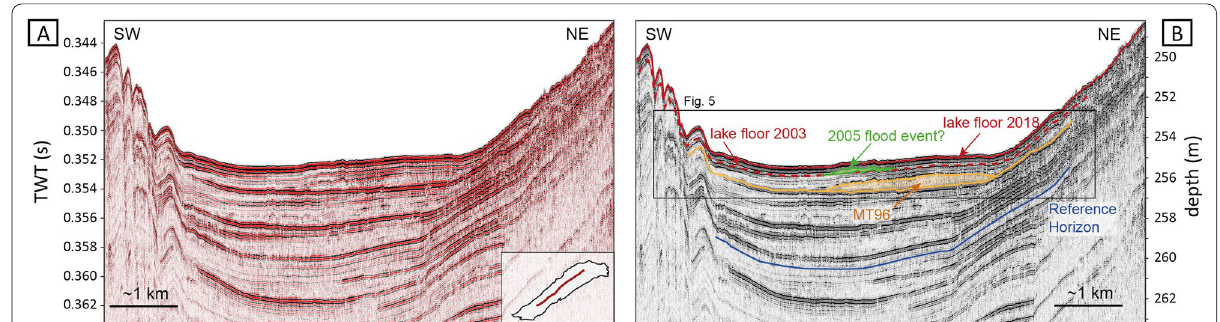
Fig. 4 Longitudinal transect of the Lake Basin as obtained from seismic data in 2018 (see inset for exact location of the reflection seismic profile). Uninterpreted seismic profile is depicted on the left. Key features like megaturbidite deposits (MT96) and current lake floor are highlighted on the right. Reference horizon for bulk shifting (synchronization between vintages) is marked in